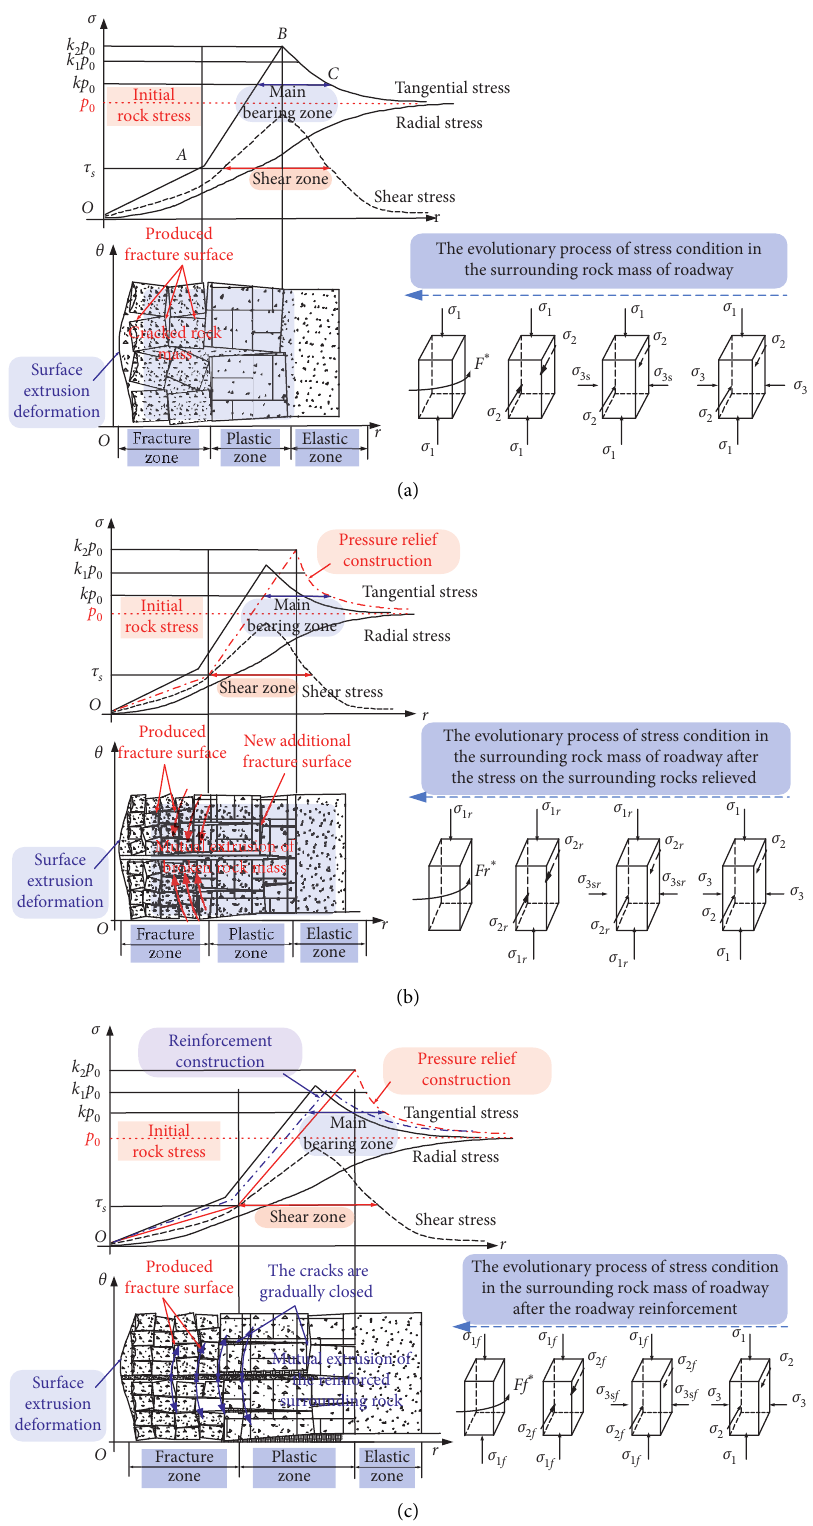
Figure 12: Evolutionary history of bearing structure of surrounding rocks and stress distribution states: (a) variation process of surrounding rock stress state after roadway excavation; (b) variation process of surrounding rock stress state after unloading; (c) variation process of surrounding rock stress state after